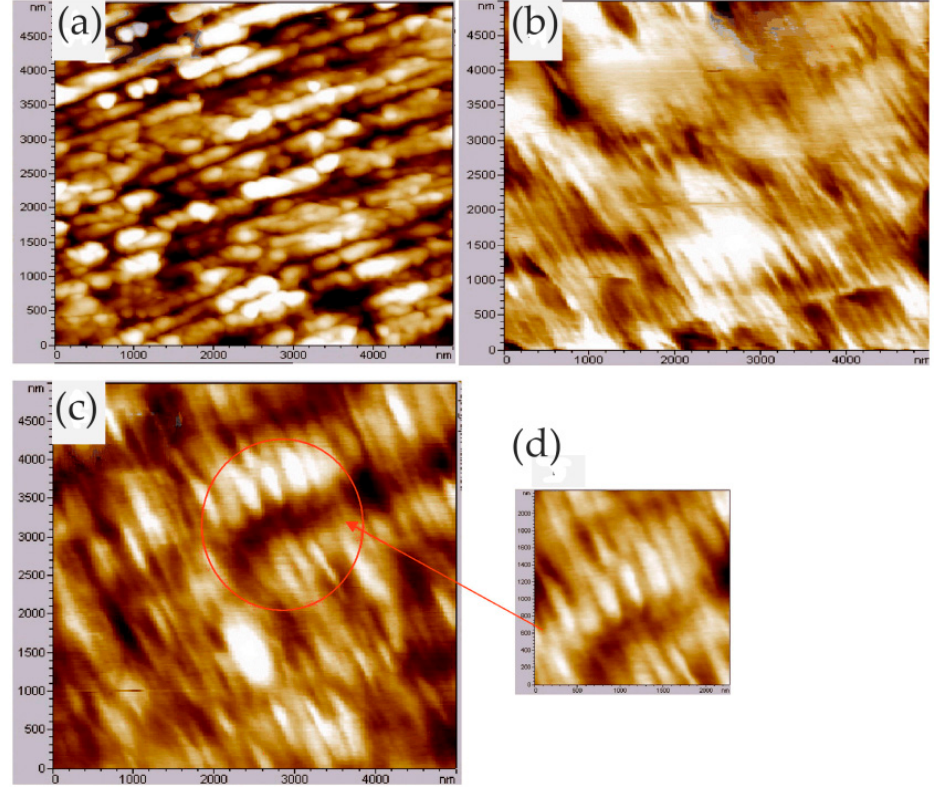
Figure 33. In situ AFM image of Al in 0.5 M H 2 SO 4 in the presence of polyacrylic acid (PAA) + KI at different potentials: ( a ) − 1.0 V, ( b ) − 0.70 V, and ( c ) − 0.50 V. ( d ) Magnified images of the framed area of ( c ). Adapted with permission from Reference [76]; copyright 2013 Taylor & Francis.